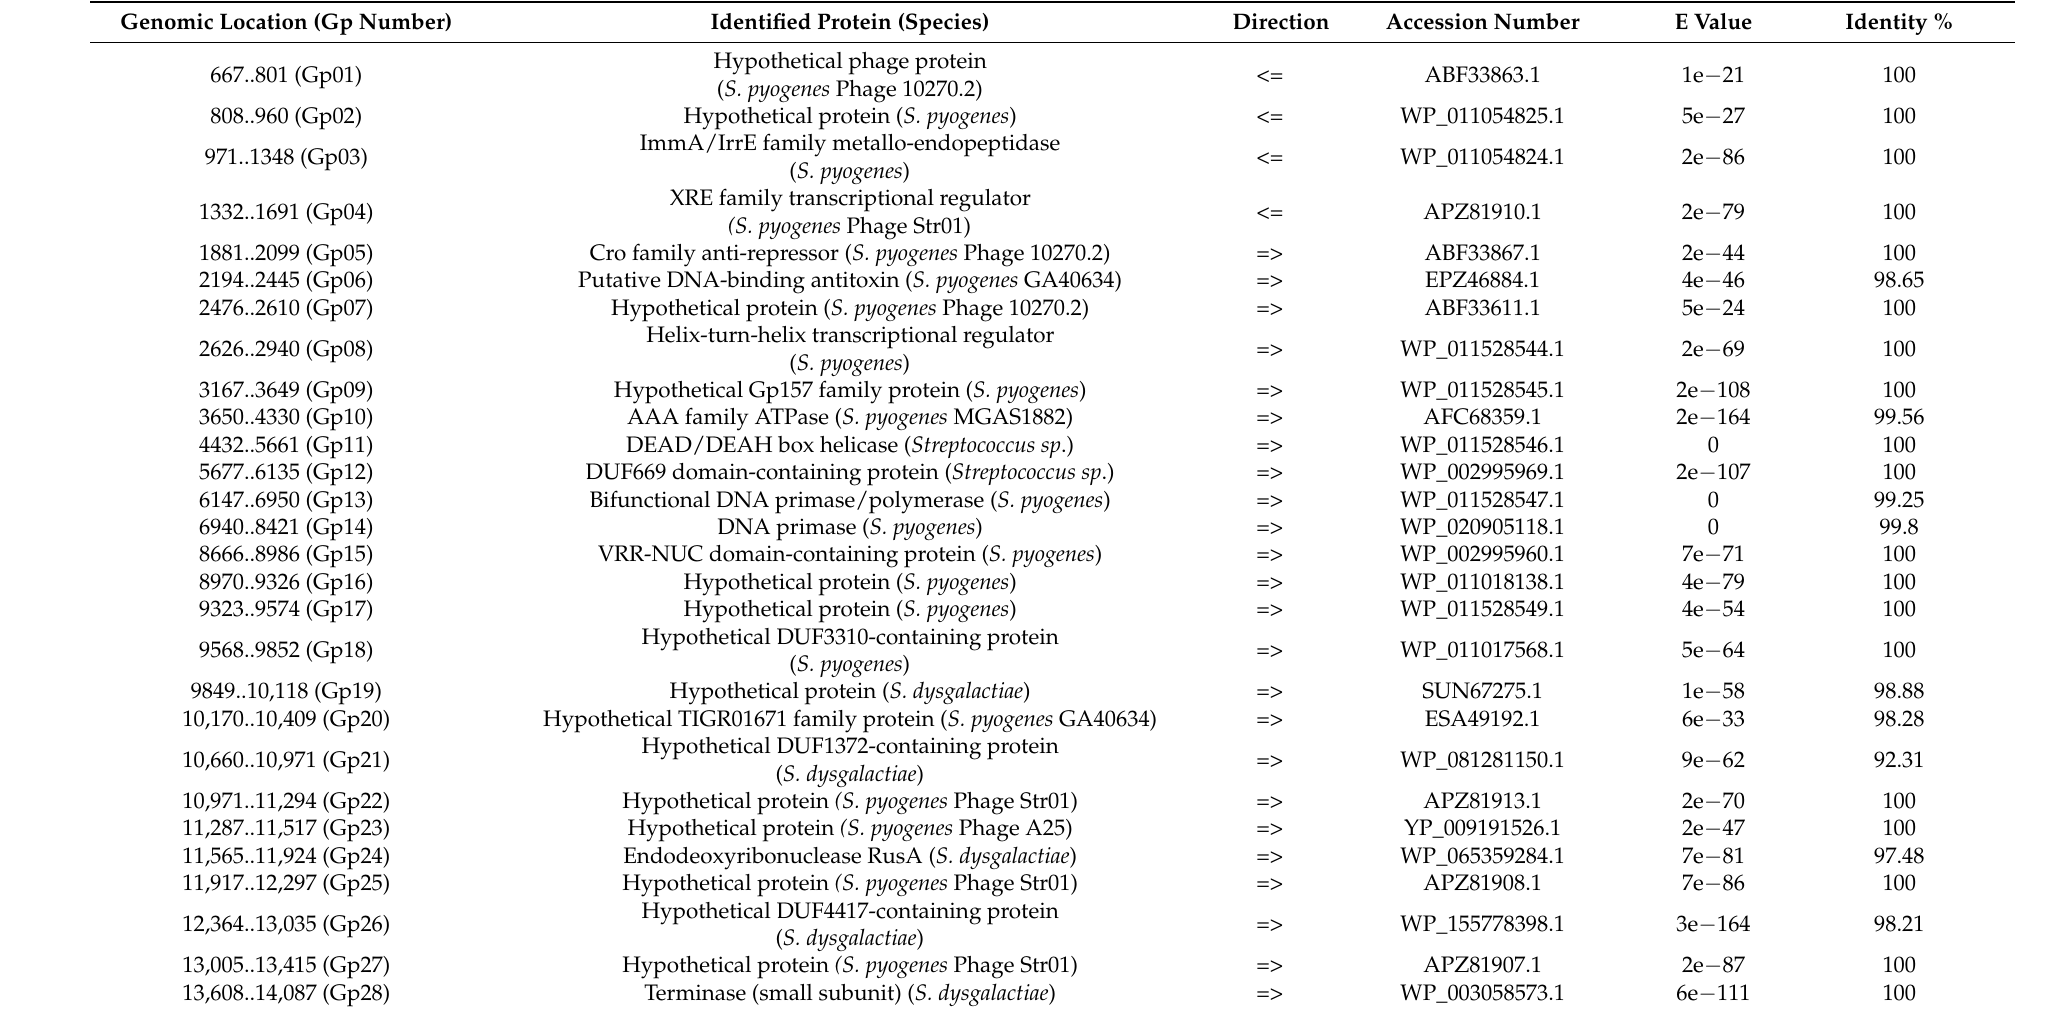
Table 3. Phage A1 genome